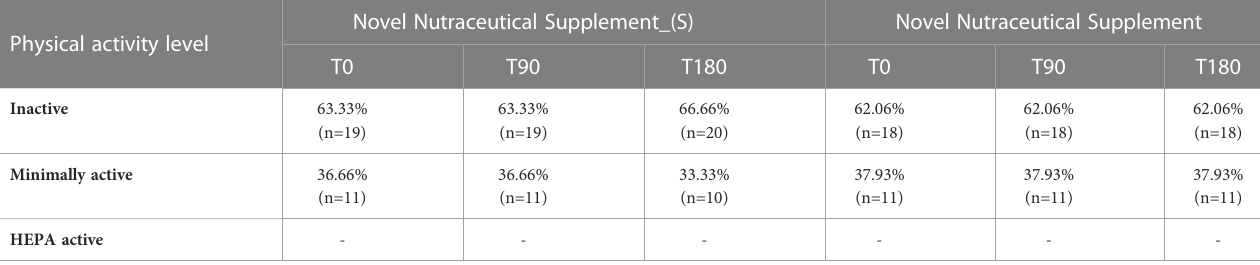
TABLE 1 Population physical activity level is classi fi ed by the International Physical Activity Questionnaire (IPAQ).